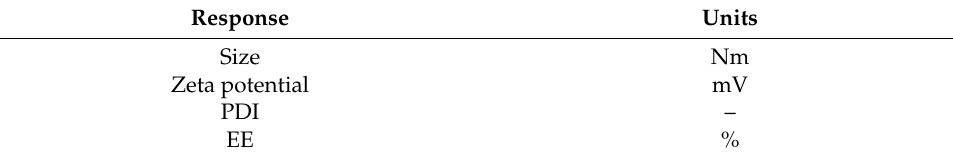
Table 4. Dependent variables in the optimization phase.